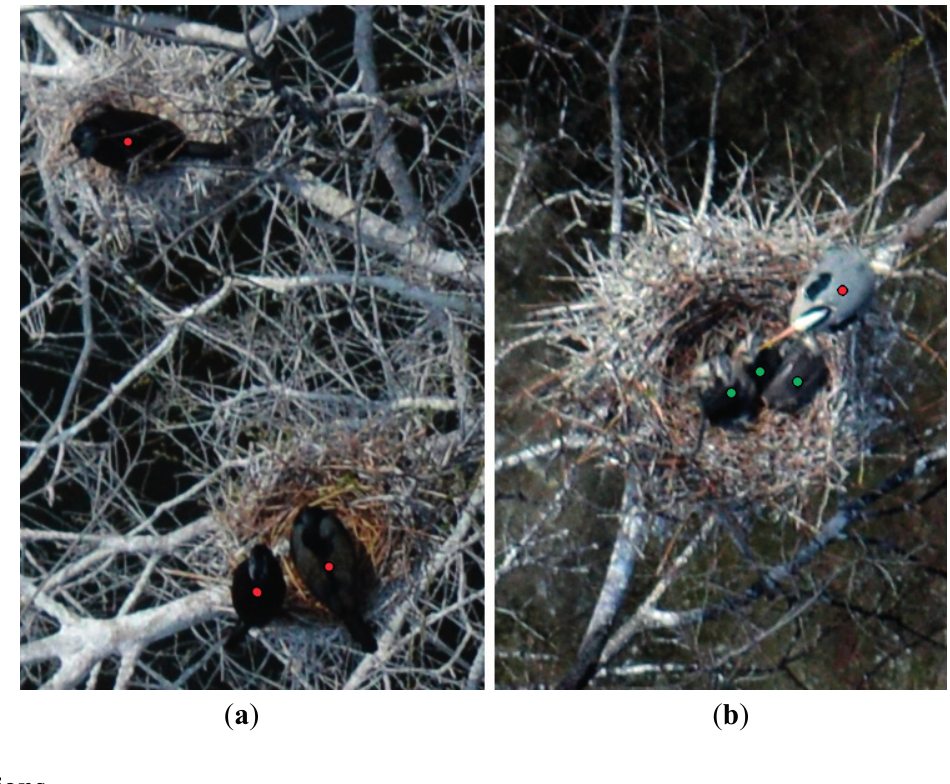
Figure 13. ( a ) Great cormorants and ( b ) gray heron nest with three hatchlings and an adult at the top of a tree in the Budapest Zoo & Botanical Garden. (Adults are marked with red points, and hatchlings are marked with green